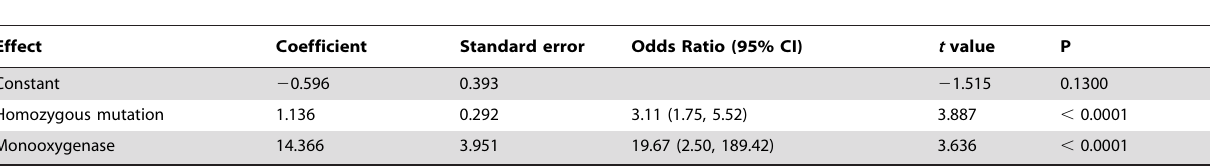
Table 5. Stepwise logistic regression for factors significantly associated with deltamethrin resistance in Anopheles